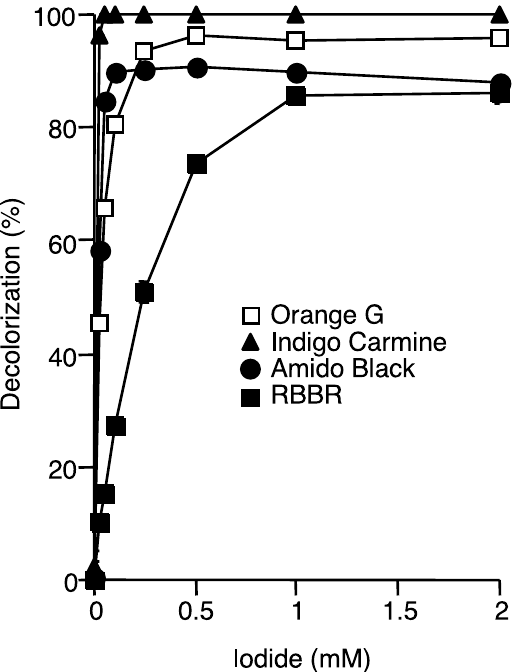
Figure 2. Effect of iodide concentration on decolorization of various dyes by IOX. The reaction mixture contained 10 mU mL − 1 of IOX, 0.3 mM each of dye, 0.025–2 mM potassium iodide, and 20 mM sodium acetate buffer (pH 5.5). The reaction mixture was incubated for 2 h (Indigo Carmine), 4 h (Amido Black), or 8 h (Orange G and